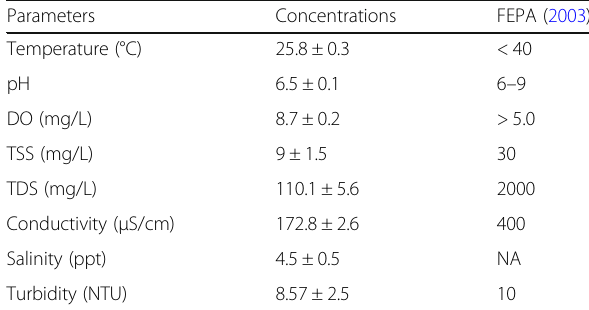
Table 1 Physiochemical parameters of water in Epe lagoon Parameters